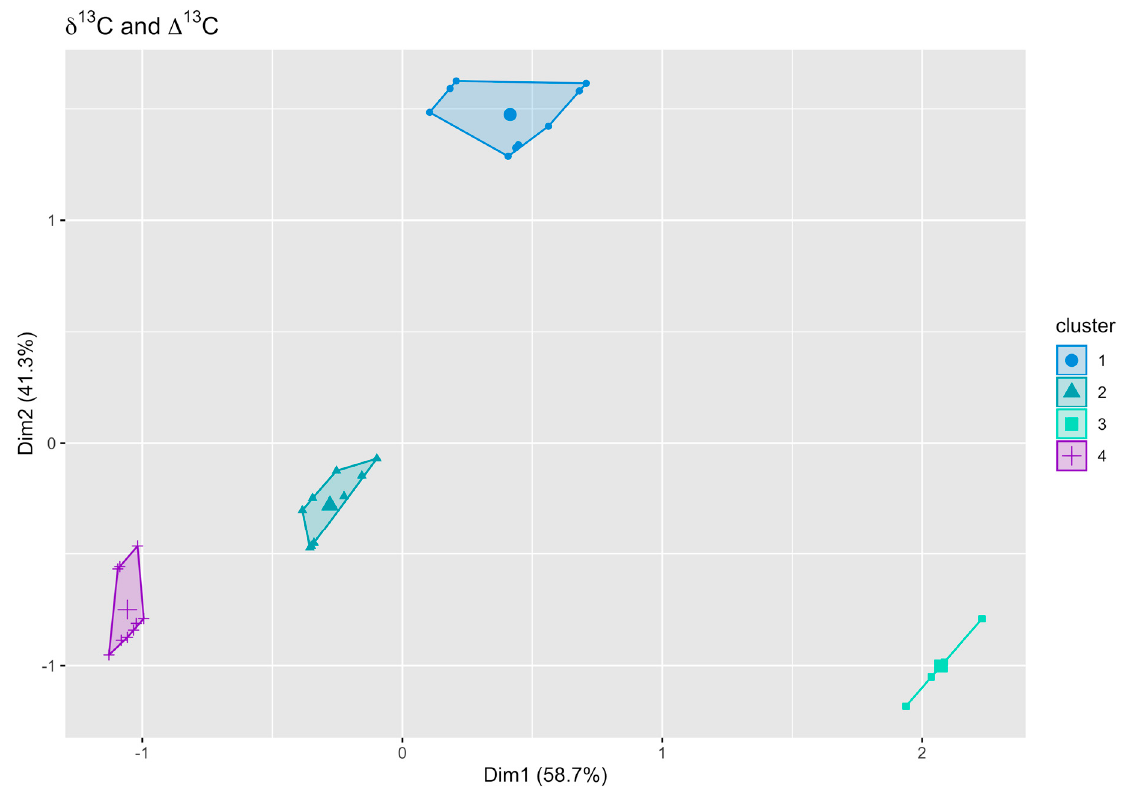
Figure 6. A cluster analysis (k-means) of the δ 13 C and Δ 13 C values of D. magna fed with different dietary sources after 96 h (for M. aeruginosa after 72 h). Cluster 1 (blue) represents the cyanobacterial diet for T. variabilis and S. elongatus (both strains); cluster 2 (turquoise) represents D. magna fed on M. aeruginosa, P. rubescens, and P. agardhii ; cluster 3 is shown in green and is formed by the chlorophytes A. obliquus, C. klinobasis, and C. vulgaris; and cluster 4 (violet) is formed by starving D. magna samples.